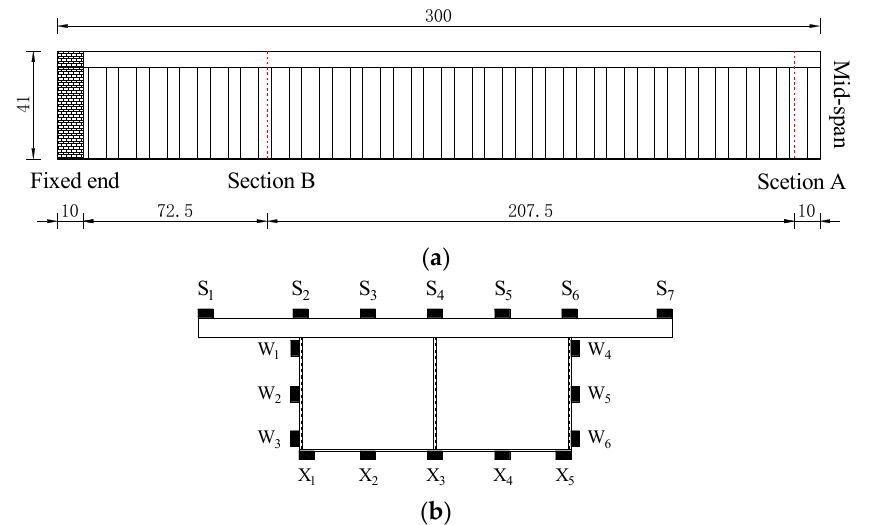
Figure 9. Test arrangement: ( a ) test section (unit: cm); ( b ) measuring point.